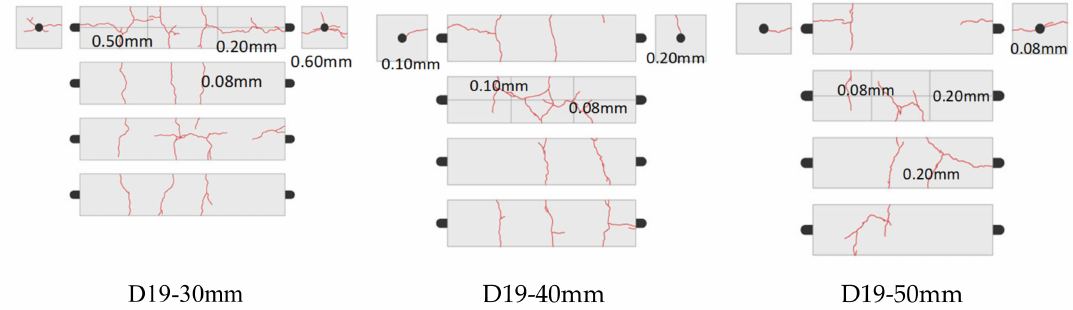
Figure 8. Crack characteristics of single reinforced concrete by induction heating (full